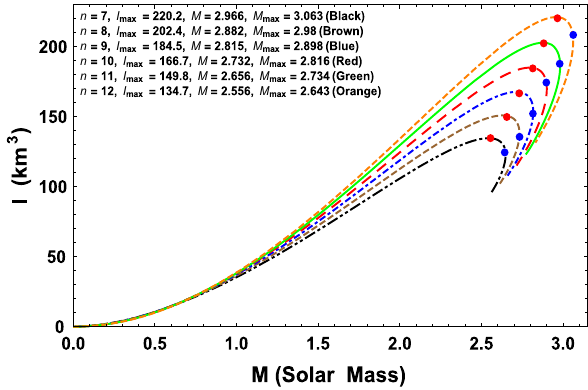
Fig. 13 M − ρ c profiles with R = 10 . 86 km and b = 0 . 04 Fig. 14 Variation of moment of inertia w.r.t. mass for a = 0 . 001 and